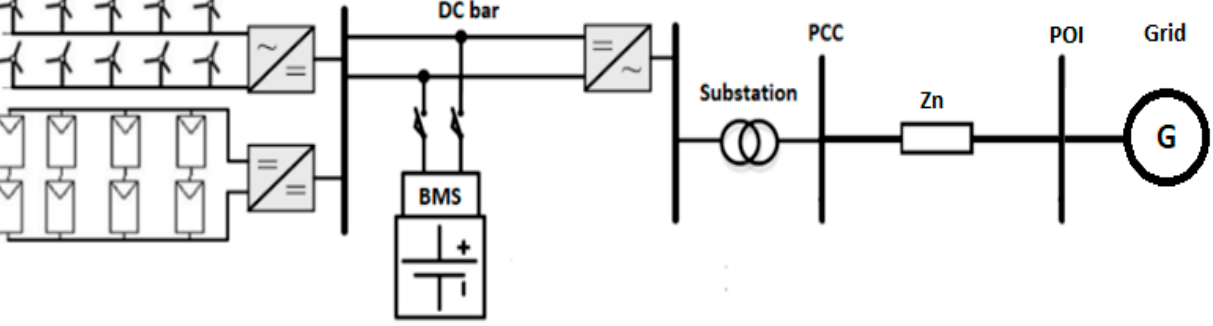
Figure 2. Single line representation of an HRPP (adapted from [38]).